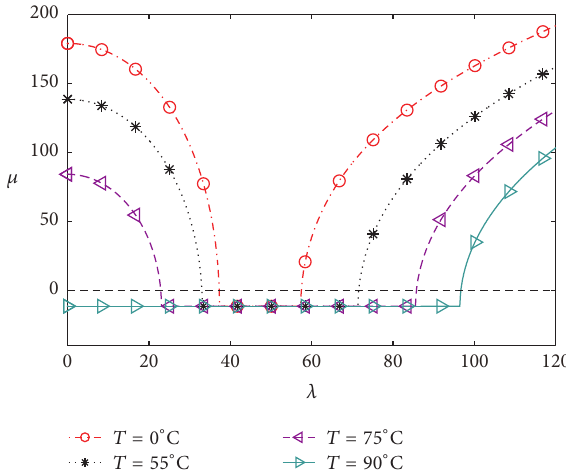
Figure 18: Influence of 𝑇 on stability boundary.